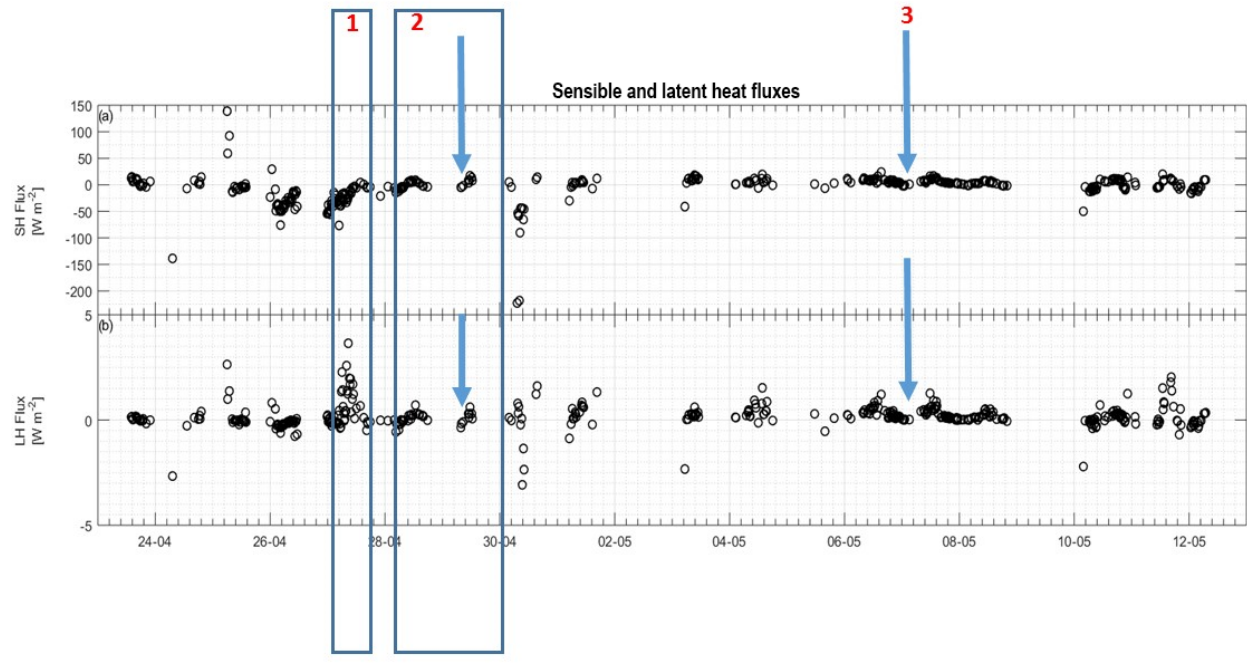
Figure 7. Sensible and latent heat fluxes in panels (a) and (b) , respectively. Both are measured in Wm − 2 , and three events are highlighted. The arrows show the specific case of stability change referred to in the text.